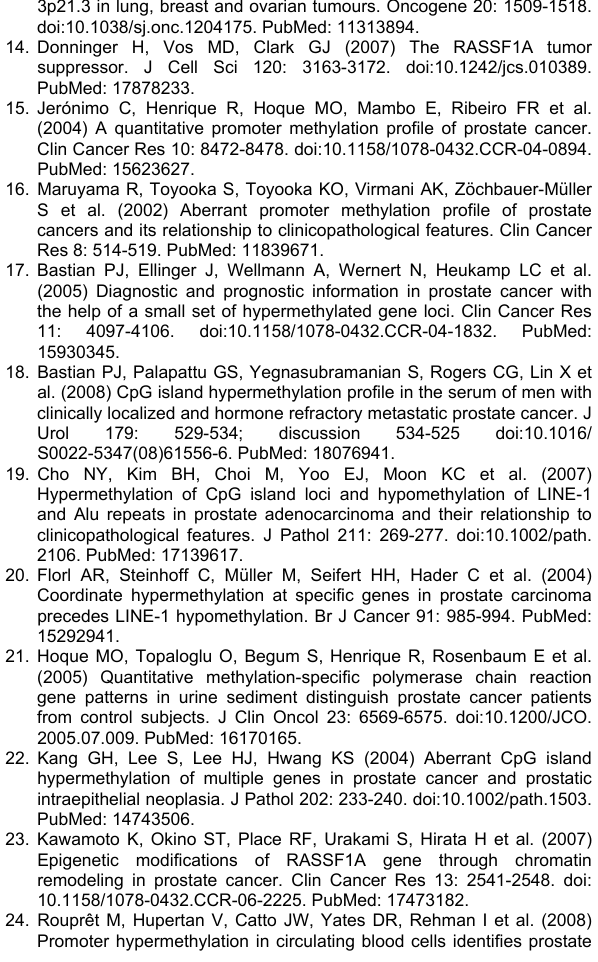
Table S2. Details of studies included in the meta-analysis: Association between RASSF1A promoter methylation and pathological stage, Gleason score, and PSA levels.